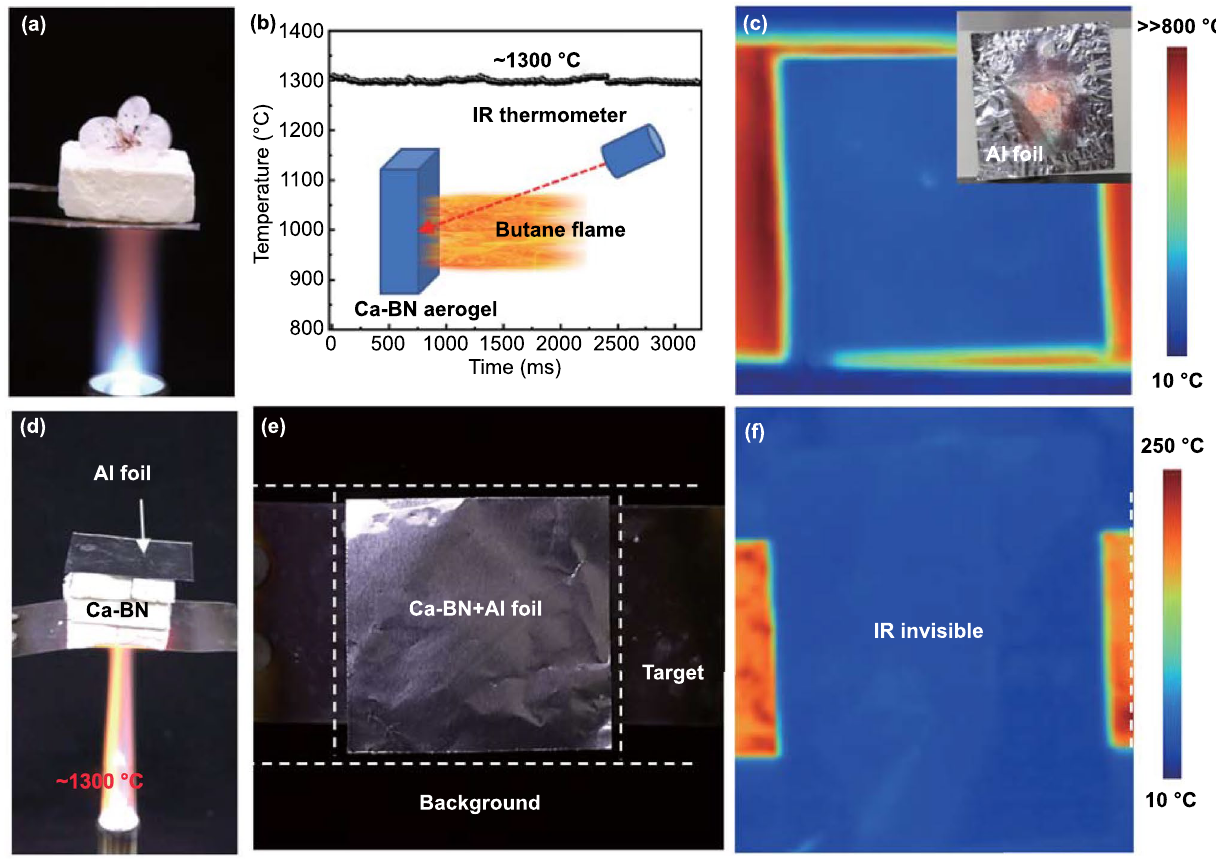
Fig. 4 a Photograph of the high-temperature thermal insulation test of Ca-BN aerogel. Ca-BN aerogel effectively insulates the flower against the fire with temperature up to ~ 1300 °C. b Temperature–time curves of Ca-BN aerogel which heated by butane flame. c IR image of hot target covered by Al foil, and the target was heated by butane flame. d – f Optical images (side view and top view) and IR image of hot target covered by Ca-BN aerogel and aluminum